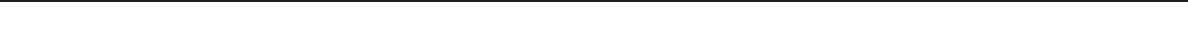
Fig. 2 uvCLAP is a quantitative and reproducible assay. a Combined ampli fi cation and sequencing of multiplexed uvCLAP libraries preserves relative quantities of signal and control libraries. Areas of light blue boxes indicate amounts of RNA, cDNA, and numbers of alignments and events. 1. After reverse transcription, libraries are combined and subjected to PCR ampli fi cation. 2. High-throughput sequencing determines nucleotide-sequences of a subset of cDNAs. 3. Reads are assigned to respective libraries according to barcodes and mapped to the genome. 4. Reads are merged into crosslinking events according to unique molecular identi fi ers (UMIs), mitigating bias from PCR ampli fi cation. 5. Peak calling utilizes information from the controls to disregard regions not enriched over background (depicted by the minus symbol in red and plus symbol in green). b Comparison of the total number of crosslinking events identi fi ed for pairwise biological replicates of 23 pulldown conditions (black) and 7 nonspeci fi c controls (red). c MA-plots comparing crosslinking event counts for pairwise biological replicates of KHDRBS2 and the corresponding background control for genomic 100 nucleotide bins covered by at least 2 crosslinking events in both replicates. The median log2 fold change is indicated in blue (see Supplementary Fig. 3 for the full set of plots for all pulldown conditions). d Log2-ratios of crosslinking events to nonspeci fi c events from background controls for 23 pulldown conditions. e Number of reads categorized as crosslinking events and PCR duplicates dependent on alignment length as proxy for cDNA insert size (see Supplementary Fig. 4 for the full set of plots for all pulldown conditions). f Clustered heatmap of pairwise Spearman correlations (deeptools2) for crosslinking events of uvCLAP replicates on